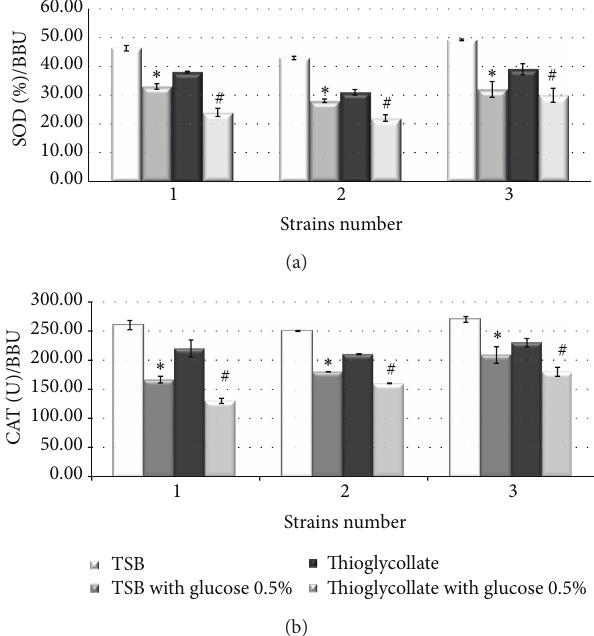
Figure2:AntioxidantdefensesinbiofilmsofSTEC:(a)SODactivity (%)/BBU and (b) CAT (U)/BBU in TSB; with addition of 0.5% glucose; in thioglycollate medium and in thioglycollate medium with addition of 0.5% glucose. Each column shows the mean ± SEM of three independent experiments. ∗ 𝑃 < 0.01 respect to TSB and # 𝑃 versus thioglycollate medium < 0.01